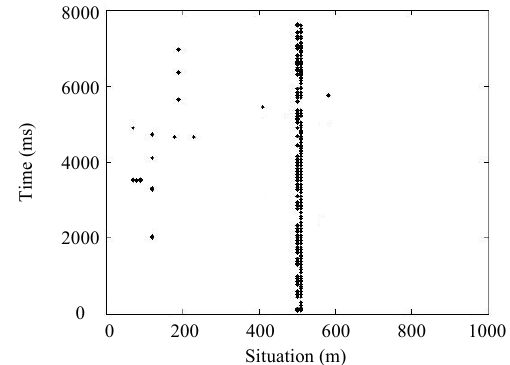
Fig. 13 Detection result of CFAR.